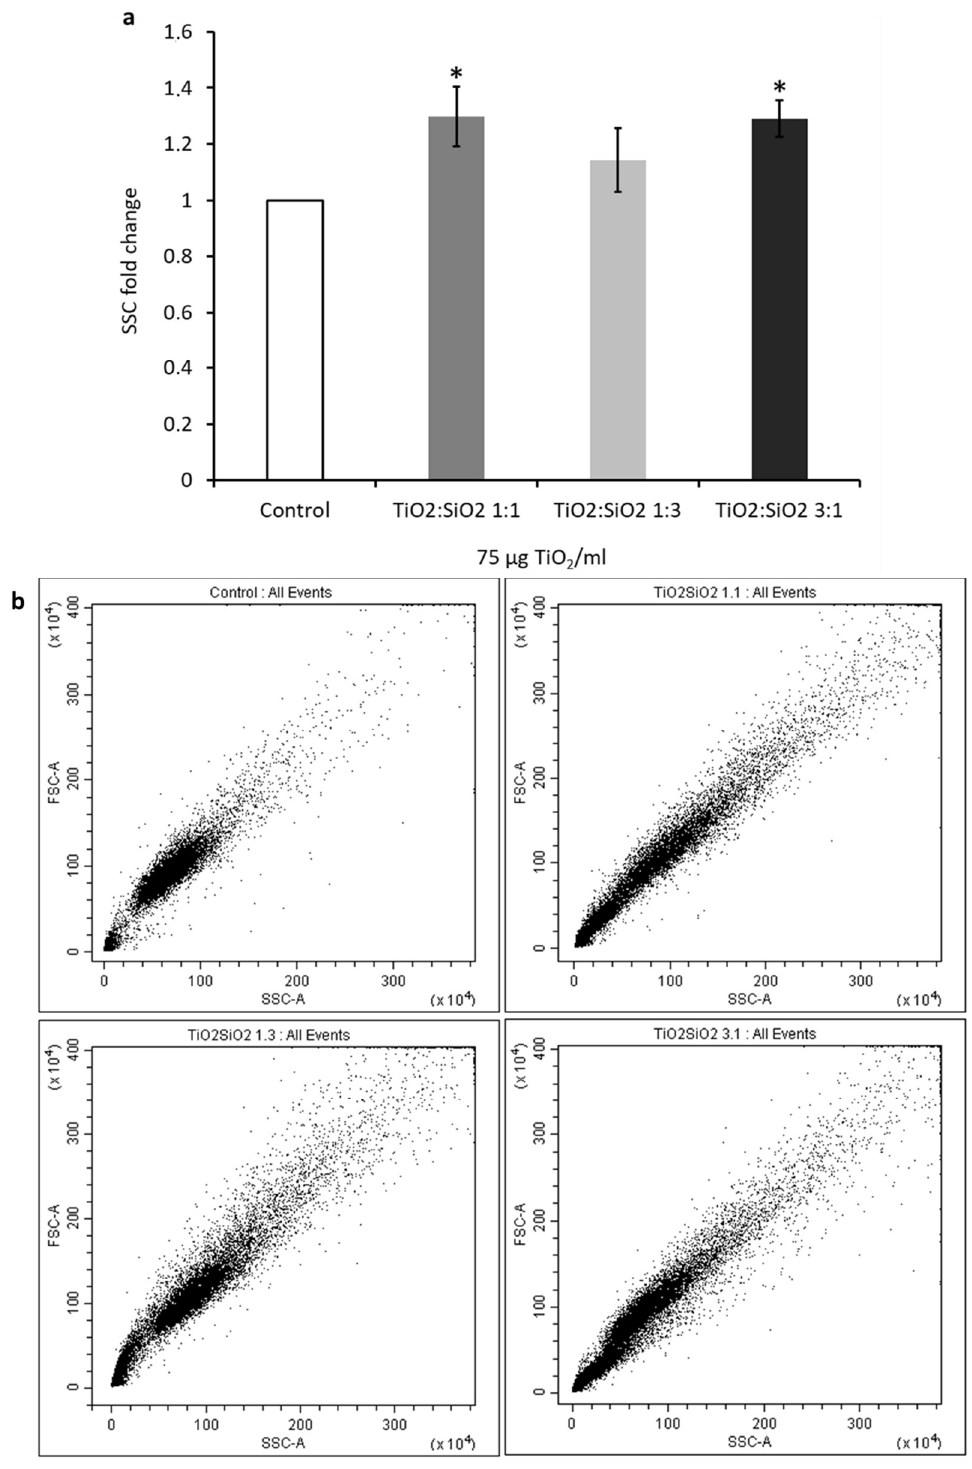
Figure 10. Cell and NP interactions after exposure for 24 h to TiO 2 :SiO 2 NPs. ( a ) The histograms show the fold change of side scatter (SSC), and data represent the mean ± SE of at least three independent experiments. ( b ) Representative dot-plots of forward scatter (FCS, y -axis) and side scatter (SSC, x -axis) of untreated cells (Control) and cells exposed for 24 h with TiO 2 :SiO 2 1:1 (1.1), 1:3 (1.3), and 3:1 (3.1) NPs. * Statistically significant with respect to control sample; unpaired t -test; p < 0.05.